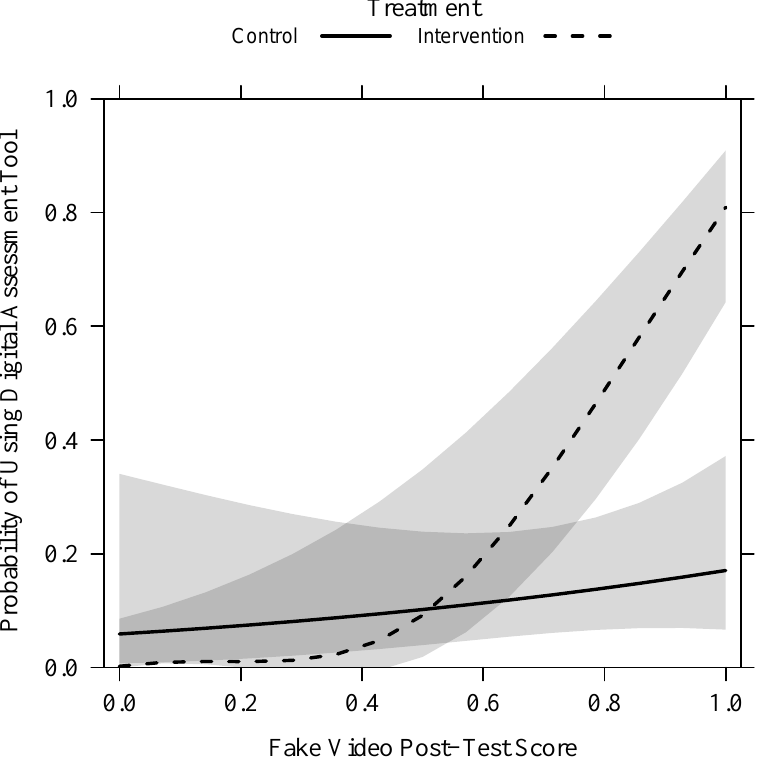
Figure 8. Probability of using digital aids as a function of the fake video post-test score and treatment